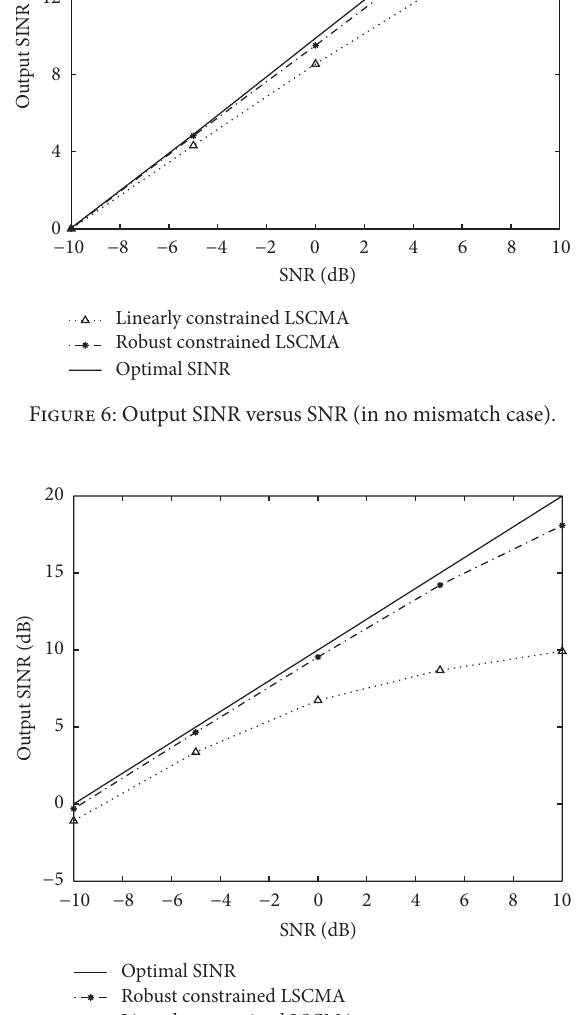
Example 3 (output SINR versus input SNR). In this experi- ment, we evaluate the SINR performance versus input SNR with DOA error for the fixed sample data size 𝑁 = 100 .